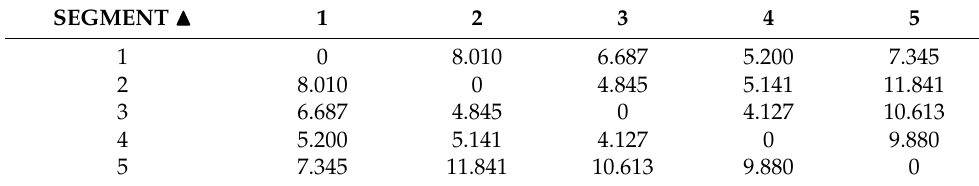
Table 1. Distance between clusters.